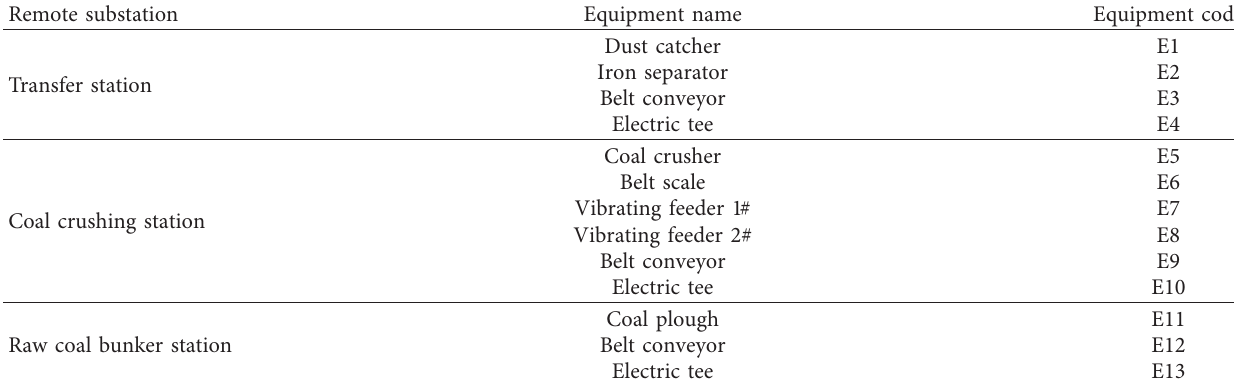
Table 3: Remote substation and its equipment